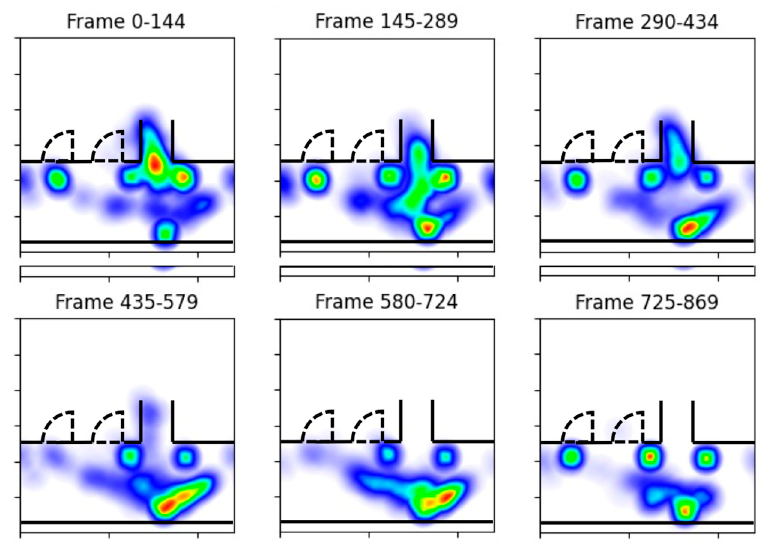
Figure 10. Heatmap visualization of crowd flow density over time in 5-s (145–frame at 29 FPS) intervals. The density map colors range from blue to red with red being the highest density.